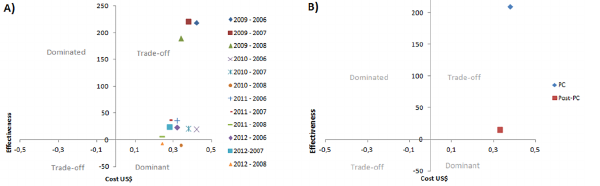
Fig 1. Cost-effectiveness plan. A) Cost-effectiveness plan of pharmaceutical care for years; B) Cost-effectiveness plan of pharmaceutical care for period. By period the mean cost and pressure control percentage of their years was used to compare periods of pharmaceutical care and post pharmaceutical care with the pre-pharmaceutical care